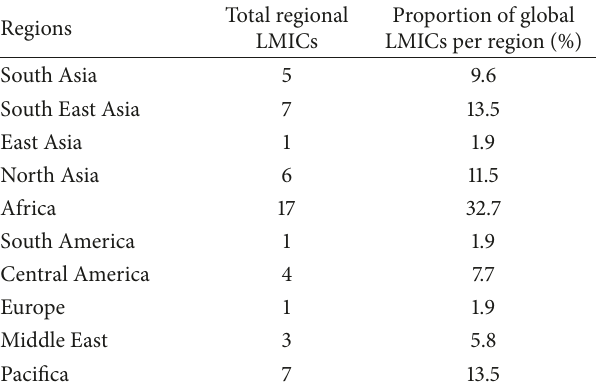
Table 2: The proportion of global LMICs per region . The proportion of LMICs in each region out of the total number of LMICs globally (52) was calculated to determine the distribution of LMICs globally.